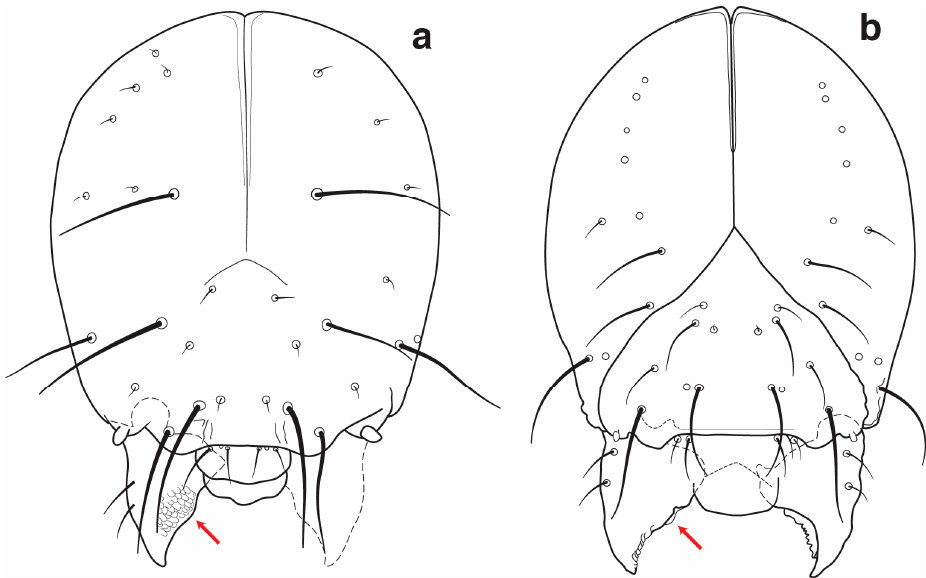
Figure 38. Head and mandibles, larva, anterior view: ( a ) Dryophthorus ; and ( b ) Diocalandra .